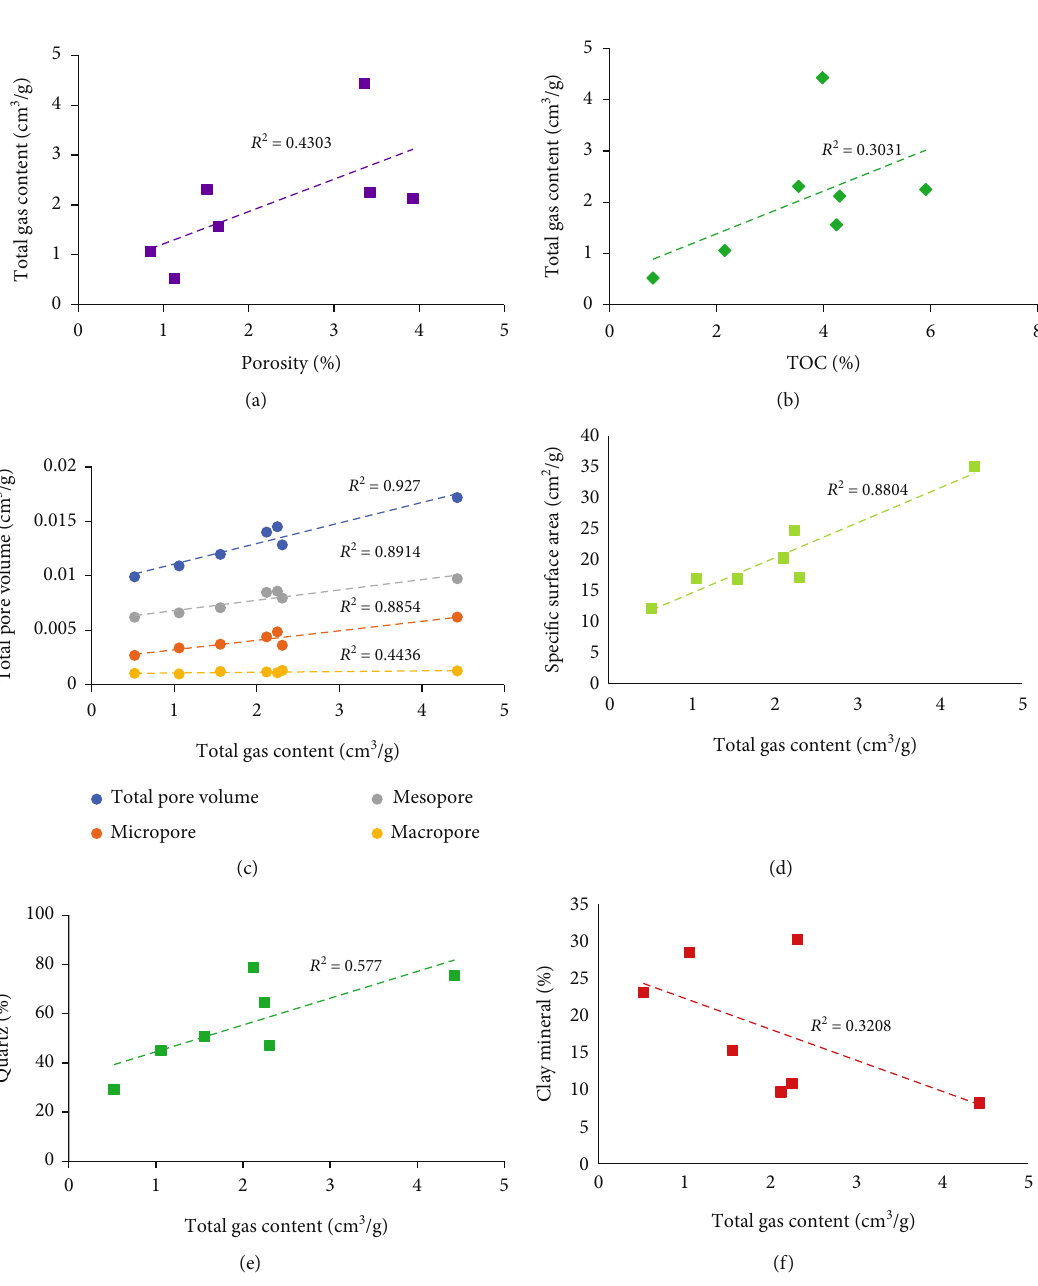
Figure 11: Correlation analysis of gas content with TOC and reservoir